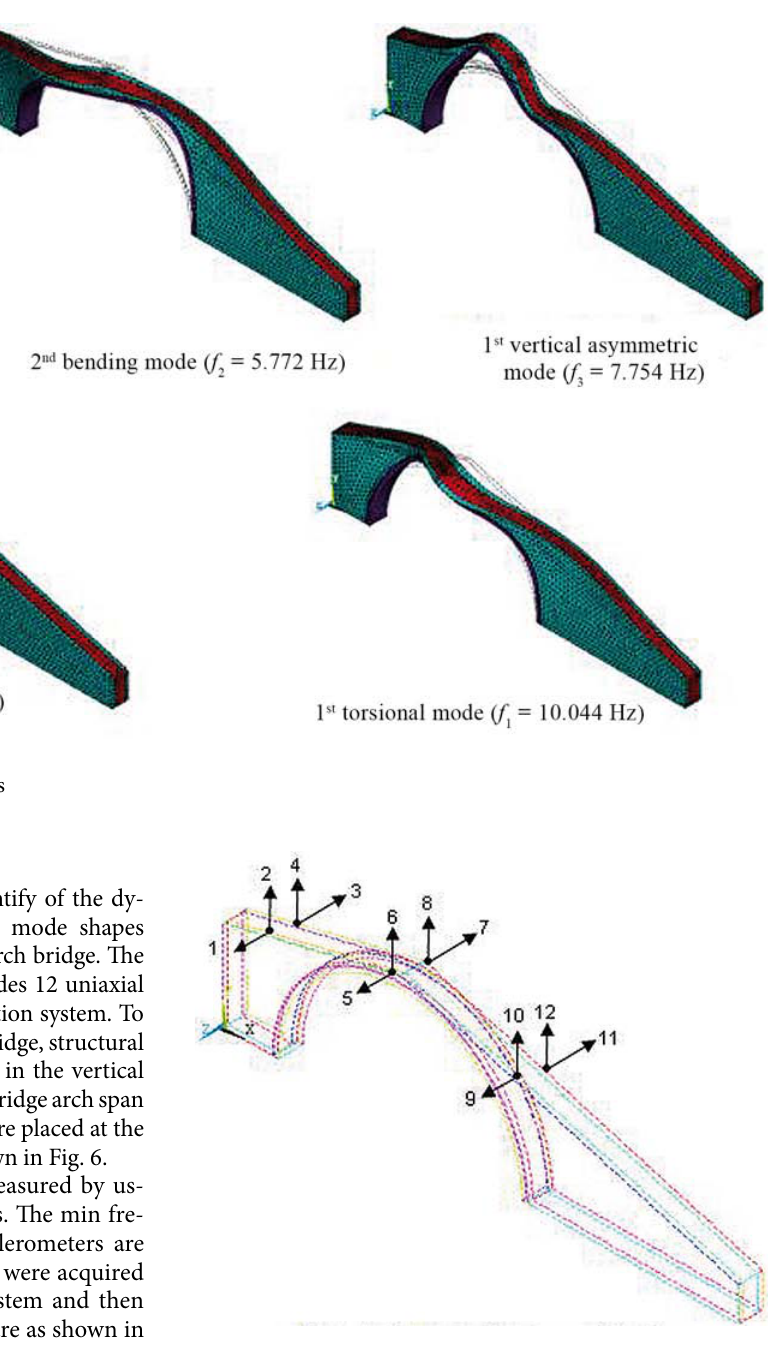
Fig. 6. Accelerometer locations on the bridge